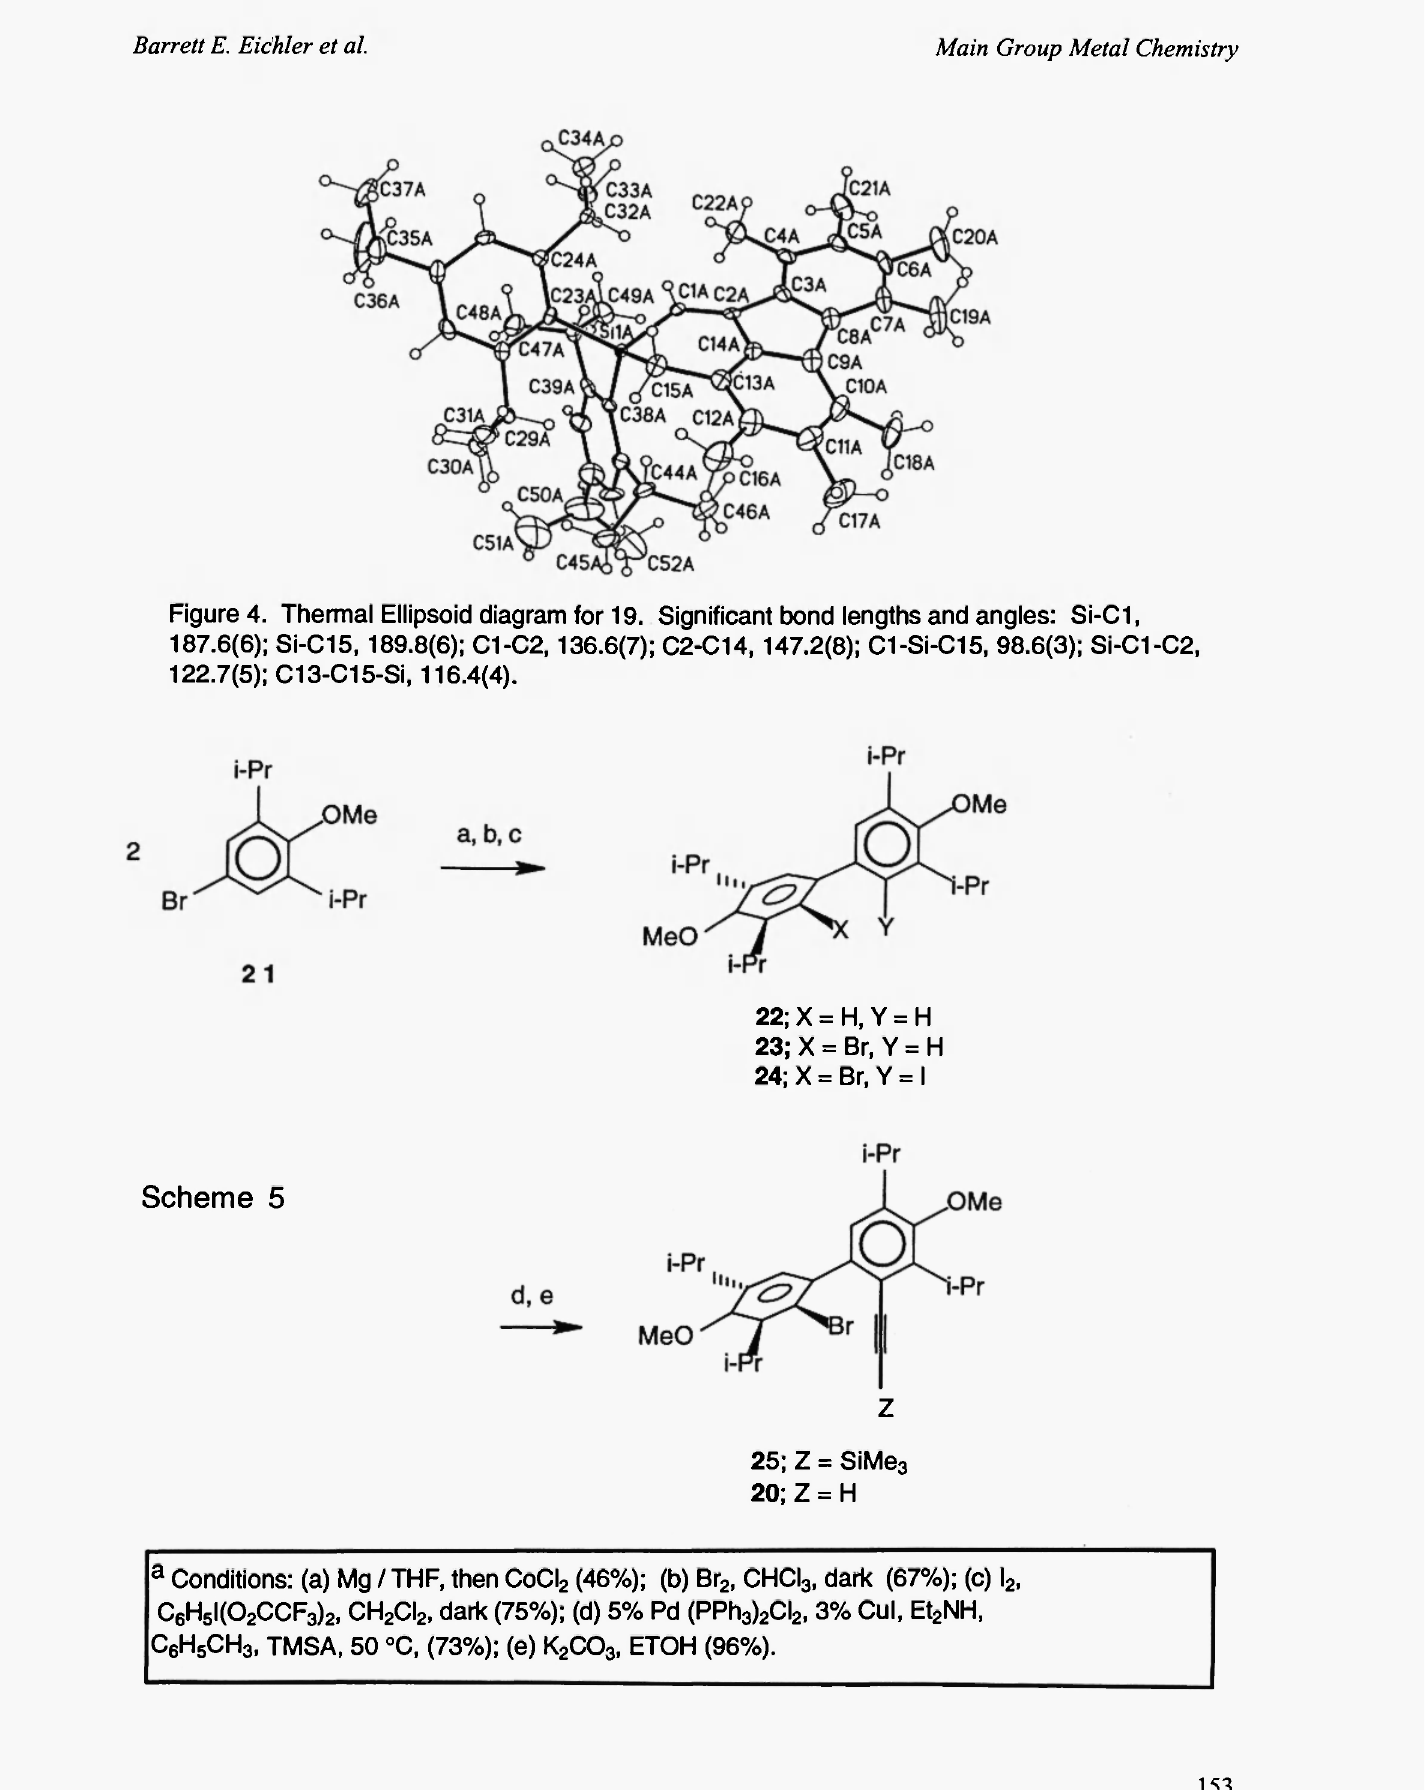
Figure 4. Thermal Ellipsoid diagram for 19. Significant bond lengths and angles: Si-C1, 187.6(6); Si-C15, 189.8(6); C1-C2, 136.6(7); C2-C14, 147.2(8); C1-Si-C15, 98.6(3); Si-C1-C2, 122.7(5); C13-C15-Si,